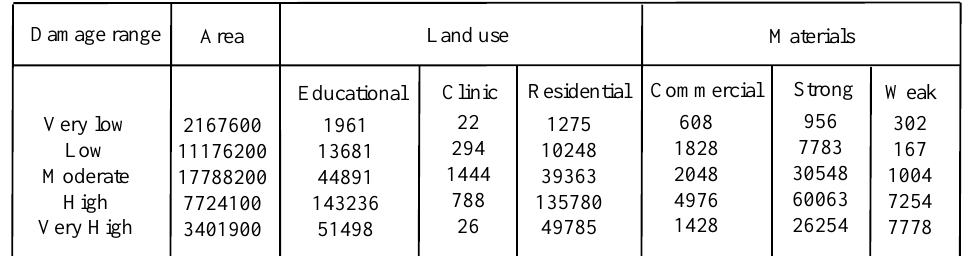
Table 6. Sanandaj Physical vulnerability based on the MCDA-RBFNN hybrid model.